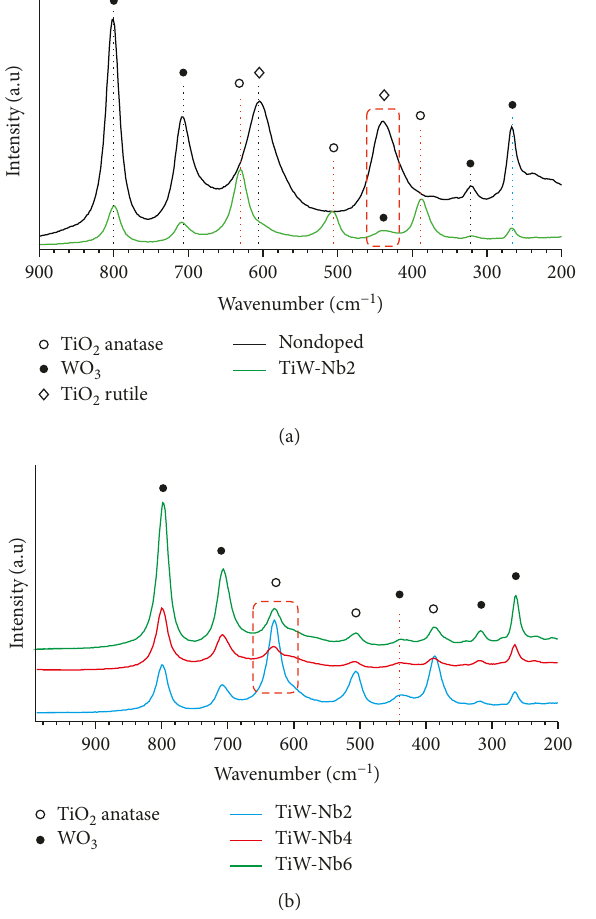
: WO Figure 4: Raman spectra of the TiO 2 3 -doped sensors: (a) nondoped and the 2% weight doped sensors; (b) 2, 4, and 6% content of Nb 2 O 5 Figure 5: Nyquist plots at 20 ° C for the samples TiW-Nb2 (a), TiW-Nb4 (b), and TiW-Nb6 (c) (black, orange, dark green, brown, rose, purple, grey, red, light blue, and light green stand for 10, 20, 30, 40, 50, 60, 70, 80, 90, and 100% RH).